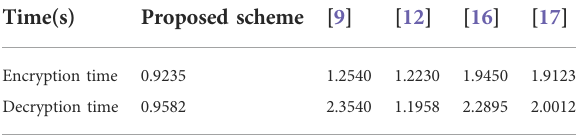
TABLE 6 Encryption and decryption time in